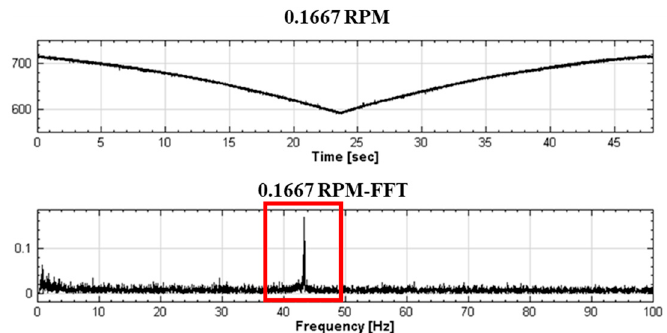
Figure 3. Working frequency of swing arm.